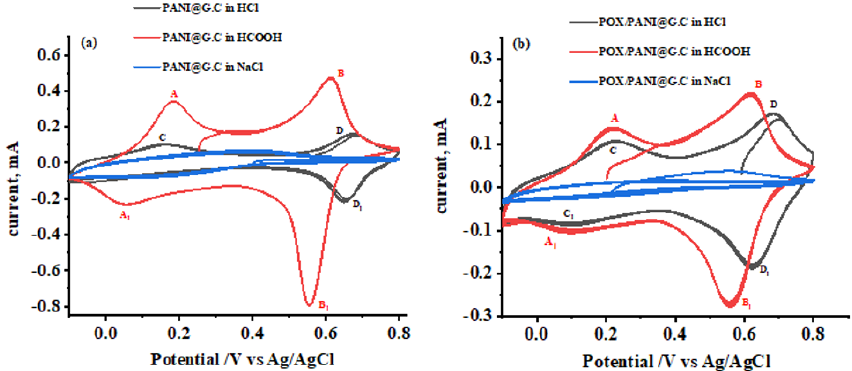
Figure 2. Cyclic voltammograms of PANI@G.C ( a ) and POX/PANI@G.C ( b ) were recorded at a 50 mV/s sweep rate in the aqueous solution of HCl, HCOOH, and NaCl.